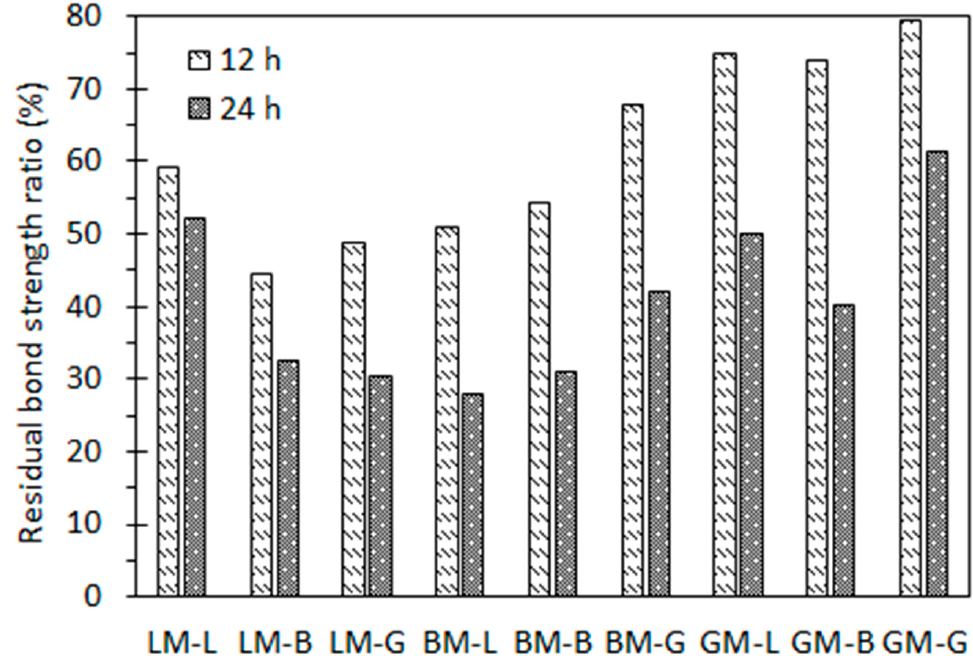
Figure 14. Residual bond strengths of asphalt mastic–aggregate interfaces under water pressure.